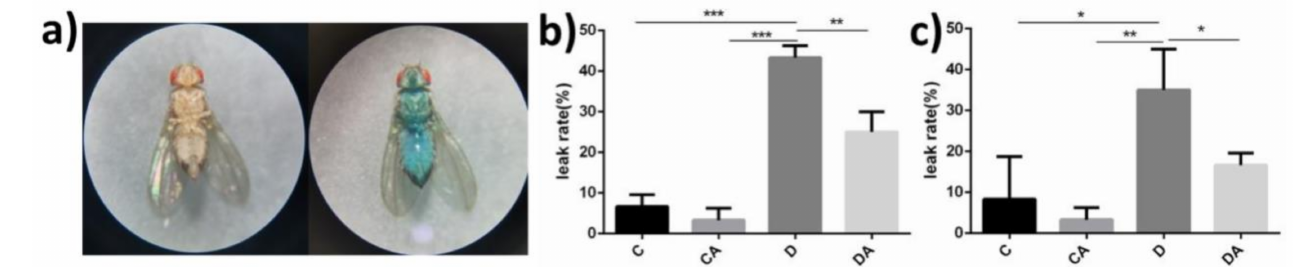
Figure 3. Effects of BANCs on the intestinal integrity of female D. melanogaster with DSS-induced inflammation. C, CA, D, and DA represent the blank control group, BANC control group, inflamed group, and BANCs + inflamed group, respectively. A blue body represents intestinal leakage in the flies (( a ), right ). Percentages of intestinal leakage in normal flies ( b ) and axenic flies ( c ). Data from triplicate repetitions are expressed as the means ± SEMs. Statistical significance: * p < 0.05, ** p < 0.01, *** p < 0.001.